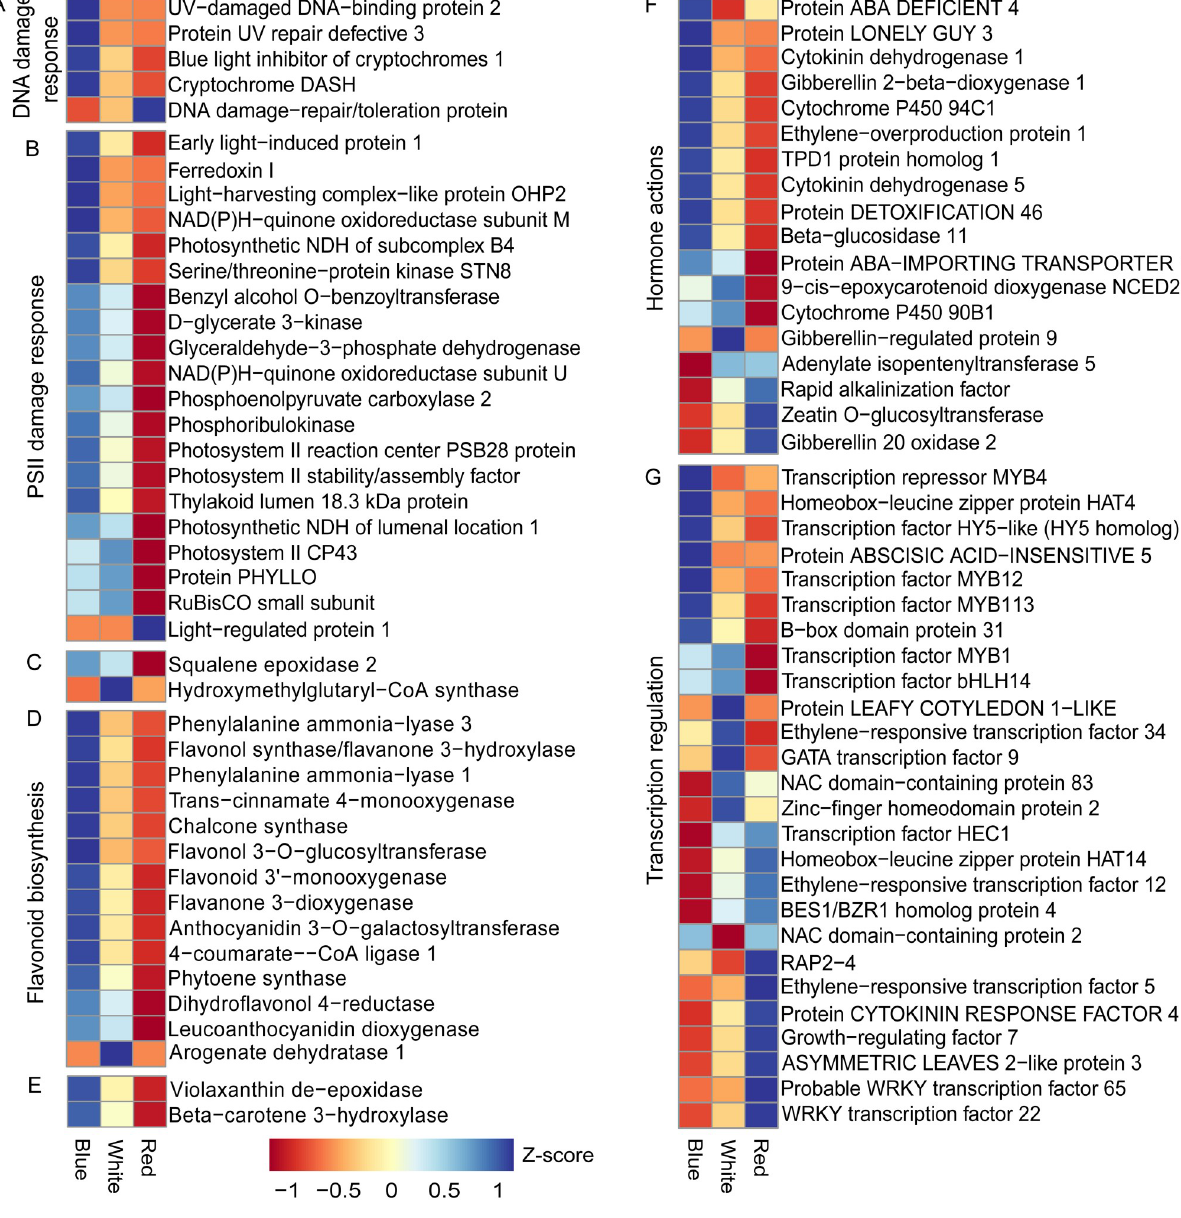
asiatic . In contrast, the down-regulation of stress responsive genes in the R-treated C . asiatic suggested a lower level of such stresses under low-energy light and the reduced expression of genes involved in secondary metabolite production might reduce the consumption of carbon and energy under photosynthetic inefficient status.